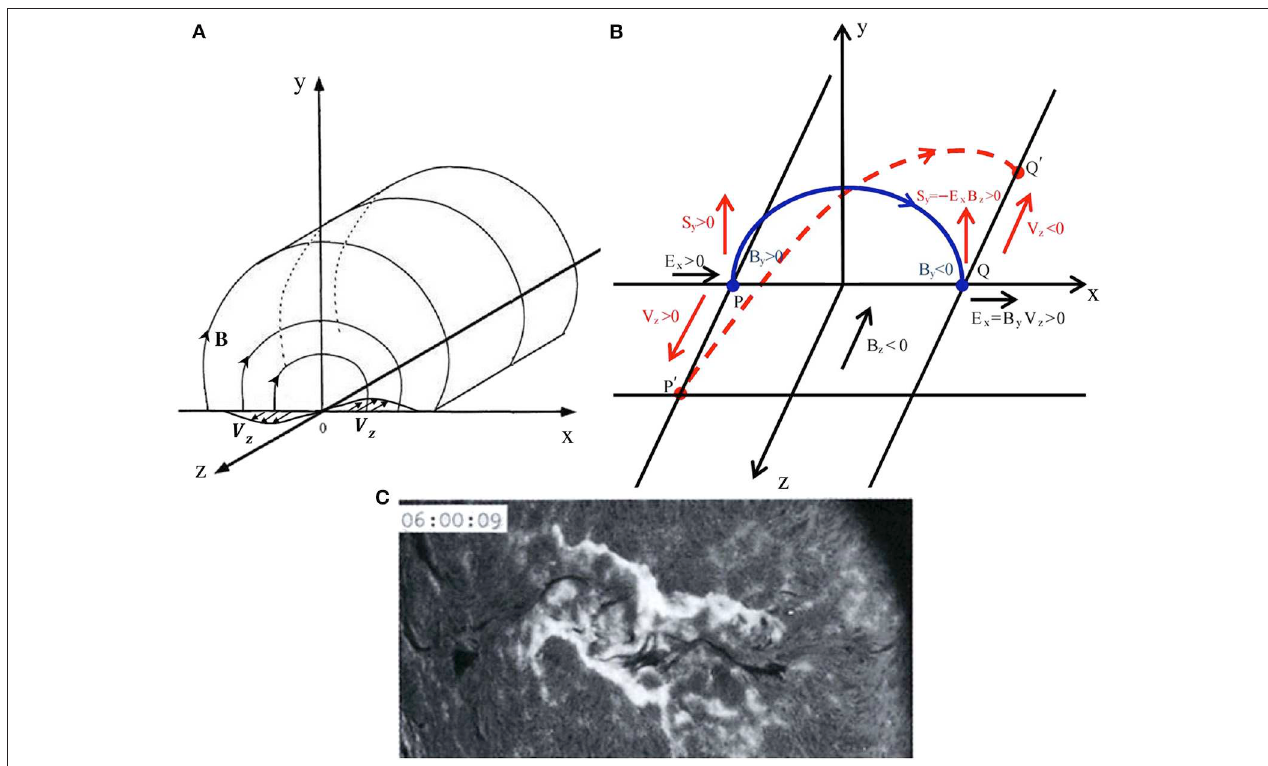
FIGURE 9 | (A) The photospheric dynamo (adopted from Figure 9 in Akasofu and Lee, 2019; permission from Elsevier Ltd.). (B) The process of generating the loop current above a two-ribbon flare by the dynamo as a result of magnetic shear (from the blue line to the dash red line), caused by the photospheric plasma flow (Akasofu and Lee, 2019). (C) An example of a two-ribbon flare with an unstable (exploding) dark filament (the Hidaka Solar Obvervatory, courtesy of E. Hiei; see also Figure 11